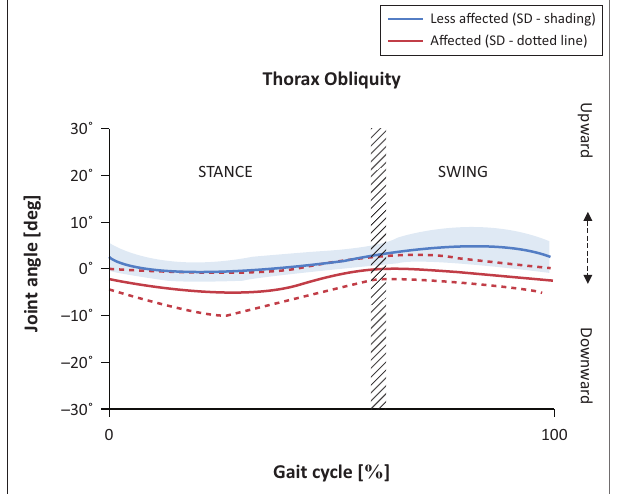
Less affected (SD - shading) Affected (SD - do(cid:11)ed line)